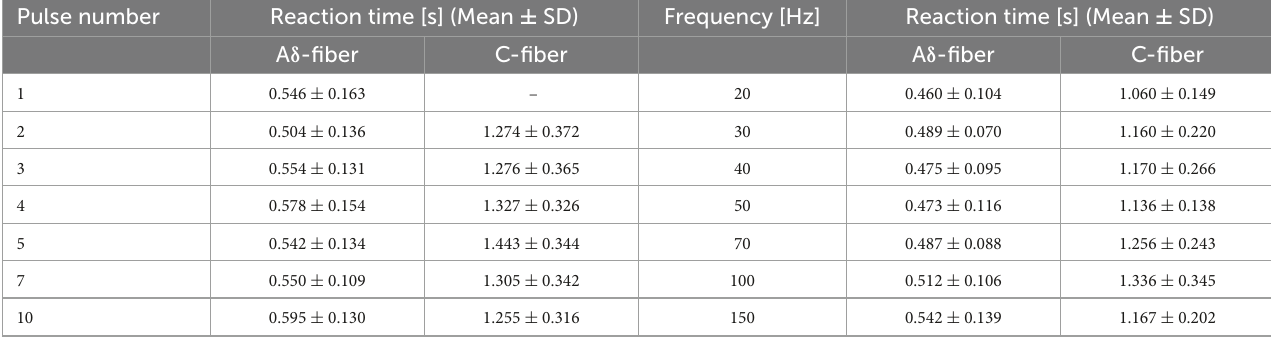
TABLE 3 Reaction time of the perception threshold at different numbers of pulses (frequency of 30 Hz) and frequencies (pulse number of four) in A δ - and C-fibers. Pulse